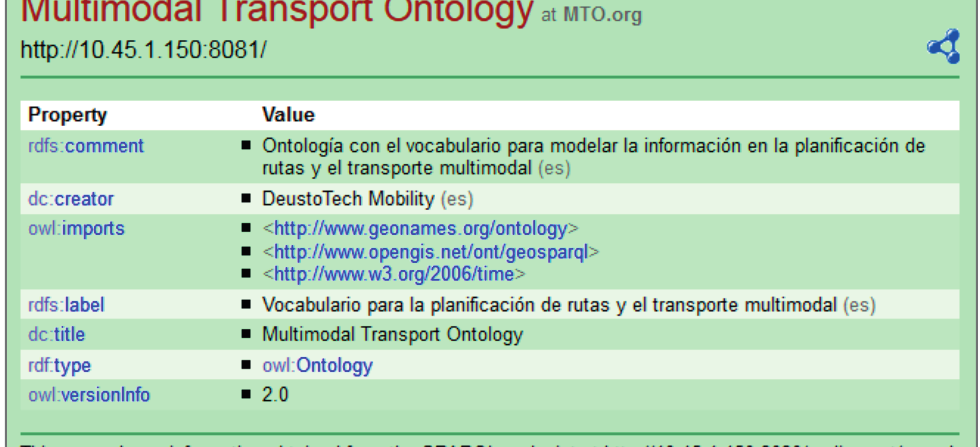
Figure 8. Deployment of Pubby for MTO information